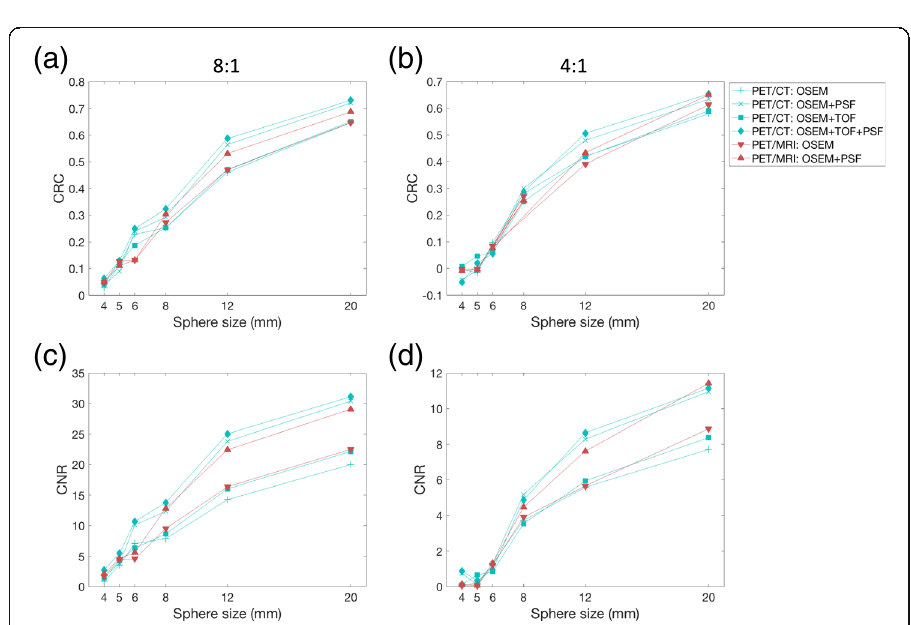
Fig. 3 Contrast recovery coefficients (CRCs) and contrast-to-noise ratios (CNRs) for the PET/CT and PET/MRI systems. CRC vs sphere size for a 8:1 and b 4:1 activity concentrations, and CNR vs sphere size for the c 8:1 and d 4:1 activity concentrations (all reconstructions with 3 iterations and 2 mm voxel